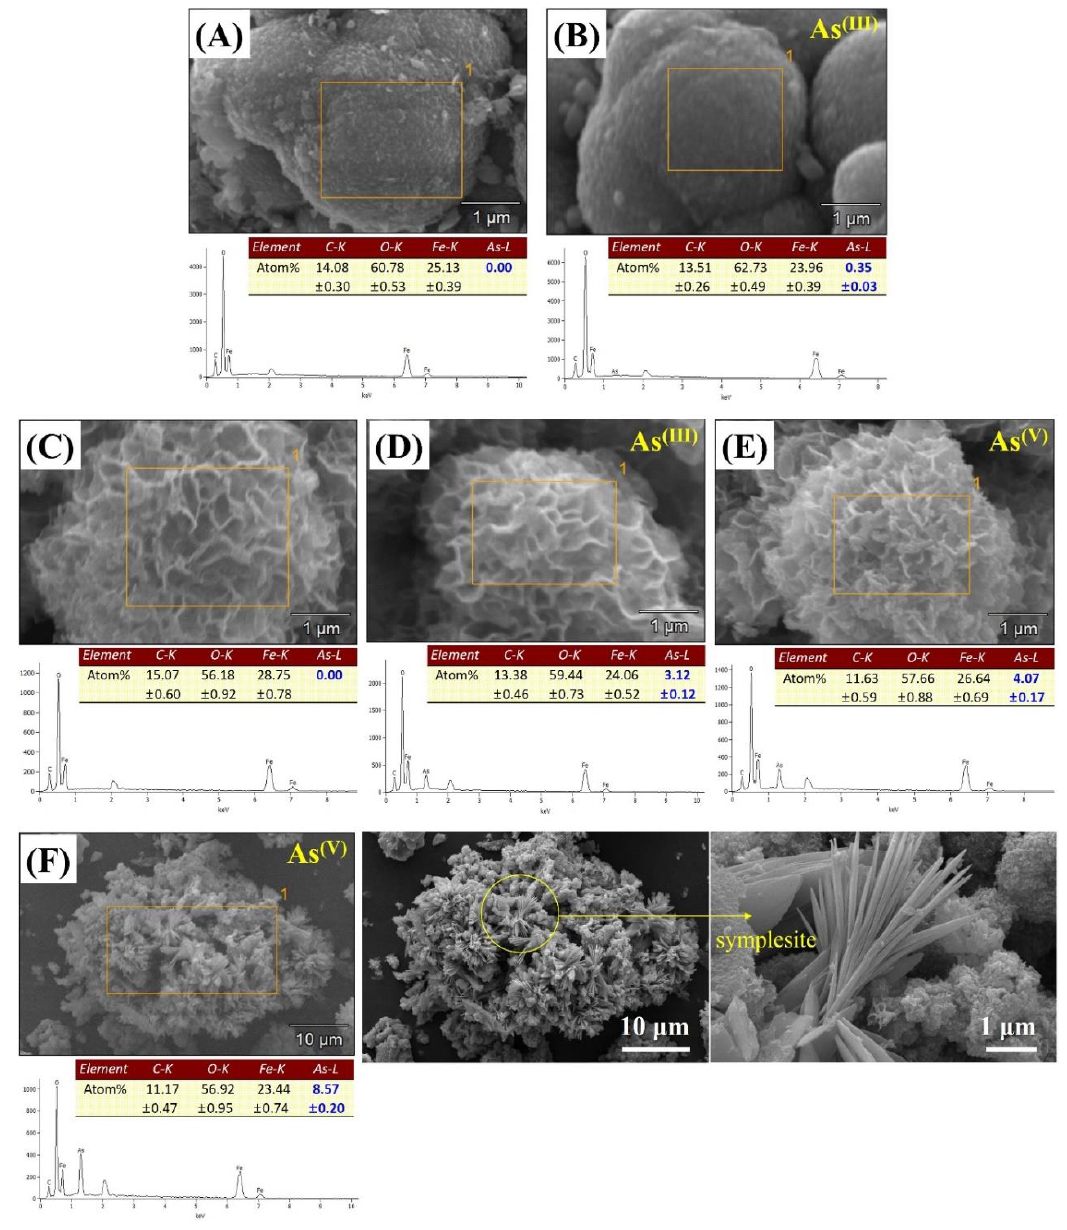
Figure 8. SEM / energy dispersive X-ray spectroscopy (EDS) results for the CF-NC samples before and after arsenic (III and V) sorption. ( A ) siderite, ( B ) As(III)-sorbed siderite, ( C ) CF-NCs, ( D ) As(III)-sorbed CF-NCs, and ( E , F ) As(V)-sorbed CF-NCs; ( F ) shows As(V)-sorbed CF-NCs with new precipitate (symplesite).